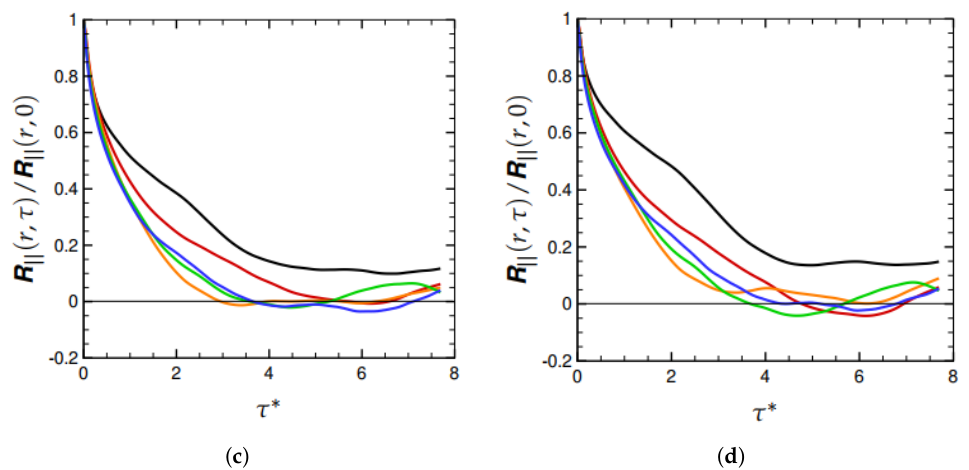
Figure 3. R || ( r , τ ) = (cid:104) ∆ u ( r , x ,0 ) ∆ u ( r , x , τ ) (cid:105) || as a function of dimensionless time separation,